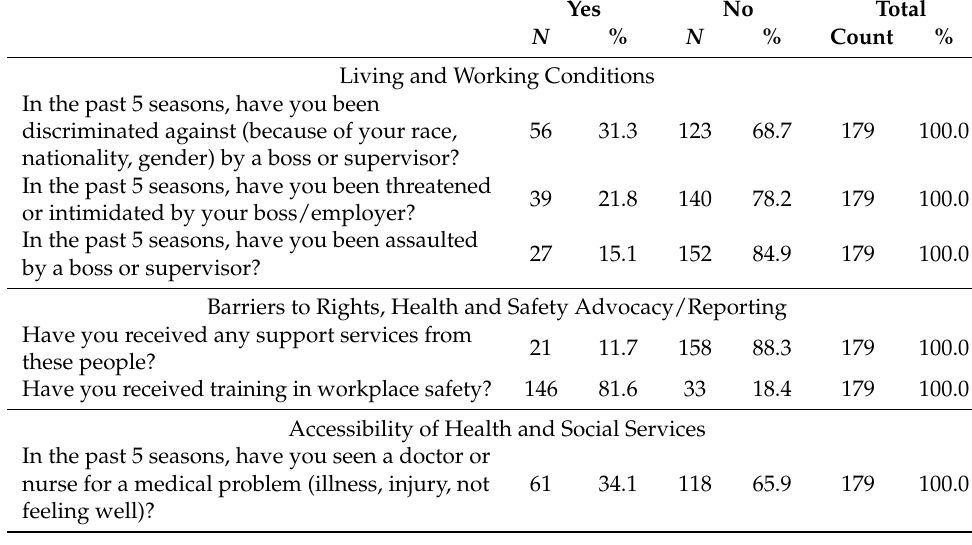
Table A1. Survey results of dichotomous questions concerning